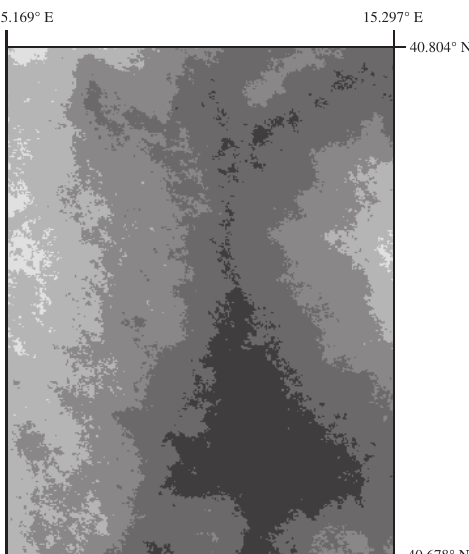
Fig. 3. Similar to fig. 2, but for the DInSAR nomi- nal surface